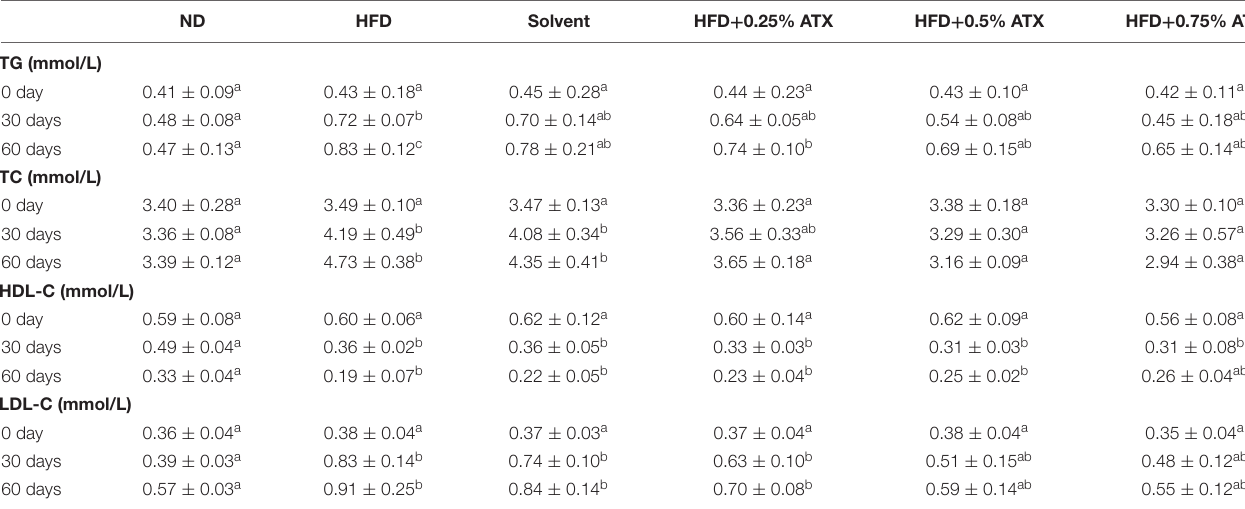
TABLE 3 | Effect of ATX supplementation on the levels of serum TG, TC, HDL-C, and LDL-C in the HFD-fed